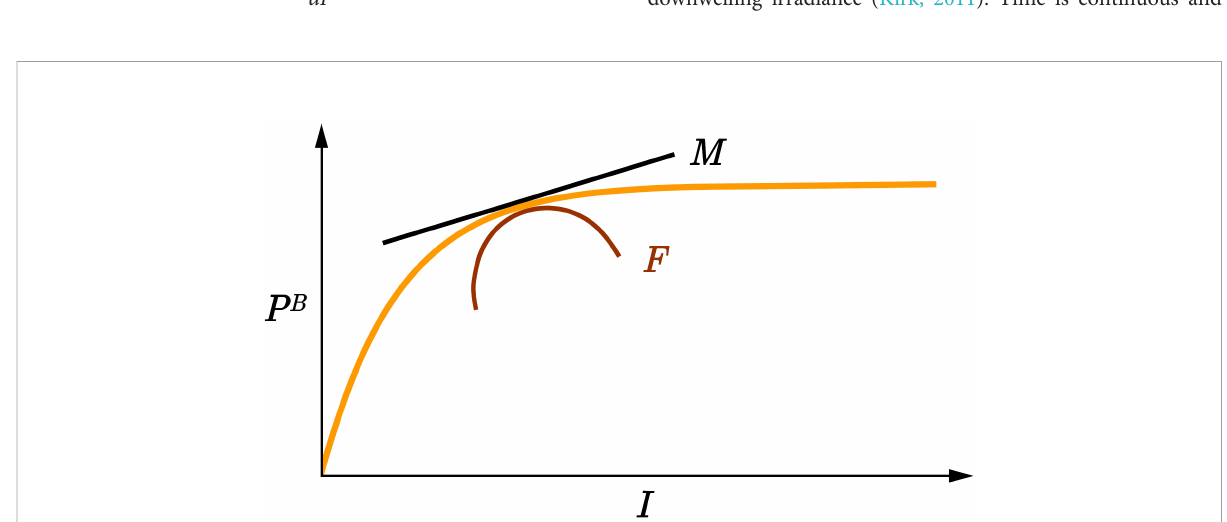
FIGURE 1 Graphical representation of marginal production M ( fi rst derivative, black) and fragility F (second derivative, red) for the photosynthesis irradiance function (orange curve), where production per unit biomass P B is given asa function of irradiance I